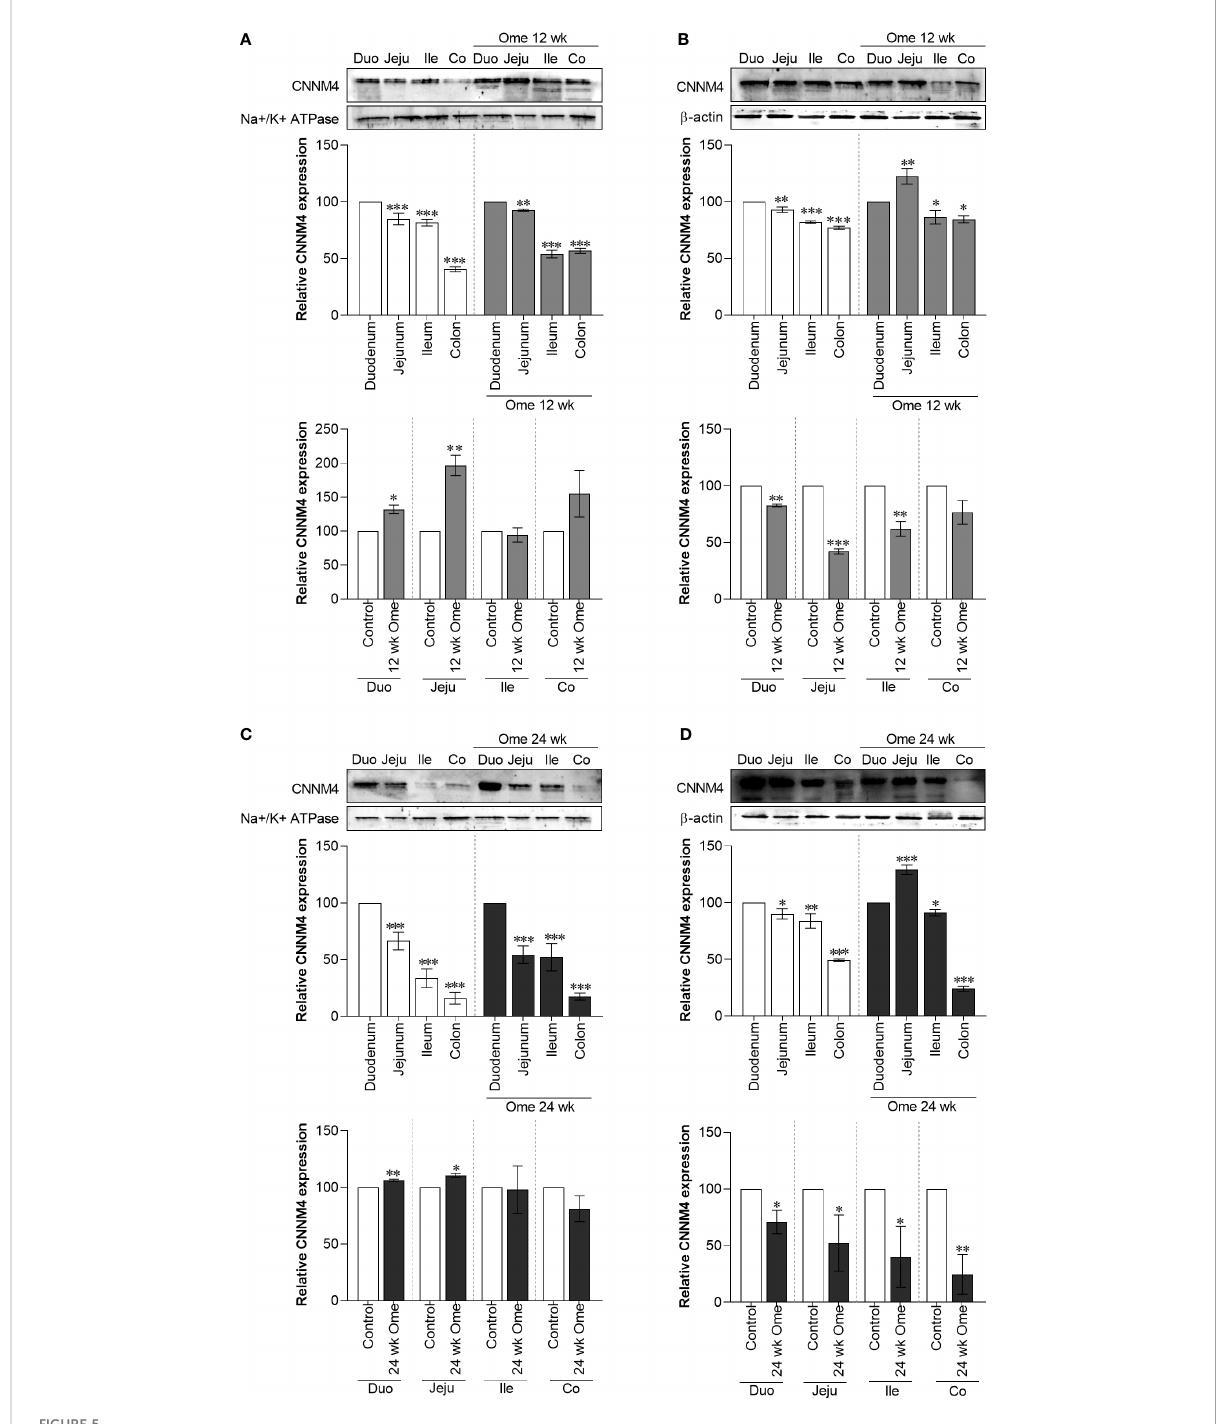
FIGURE 5 Membrane CNMM4 (A) and cytosolic CNMM4 (B) expression in duodenum, jejunum, ileum, and colon of control or 12 wk omeprazole-treated rats. Membrane CNMM4 (C) and cytosolic CNMM4 (D) expression in duodenum, jejunum, ileum, and colon of control or 24 wk omeprazole- treated rats. The upper relative expression graph; the protein expression in jejunum, ileum, and colon was relatively compared to that of in the duodenum. The lower relative expression graph; the protein expression in duodenum, jejunum, ileum, and colon of omeprazole-treated groups was relatively compared its corresponding segment of control group. Duo, duodenum; Jeju, jejunum; Ile, ileum; Co, colon; ome, omeprazole. * P < 0.05, ** P < 0.01, *** P < 0.001. ( n =